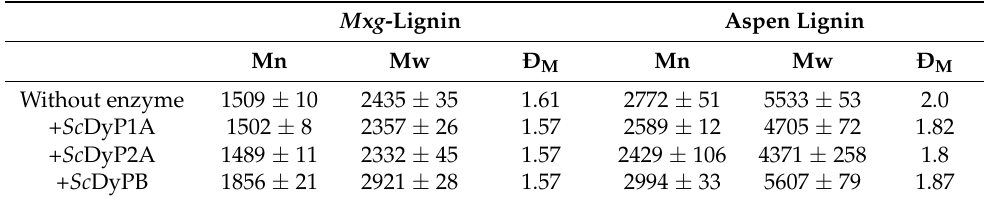
Table 4. Mn, Mw, and the molar-mass dispersity (Ð M ) of M x g - (panel A) and aspen (panel B) ethanol organosolv lignins treated with Sc DyPs determined by GPC analysis. Solutions containing lignins at 1 mg/mL in HEPES buffer (pH 8.0) and 2 mM H 2 O 2 without enzymatic treatment, or treated with 10 µ M enzyme were incubated for 24 h. Samples were centrifuged, pellets lyophilized and dissolved, and the lignins were analyzed using